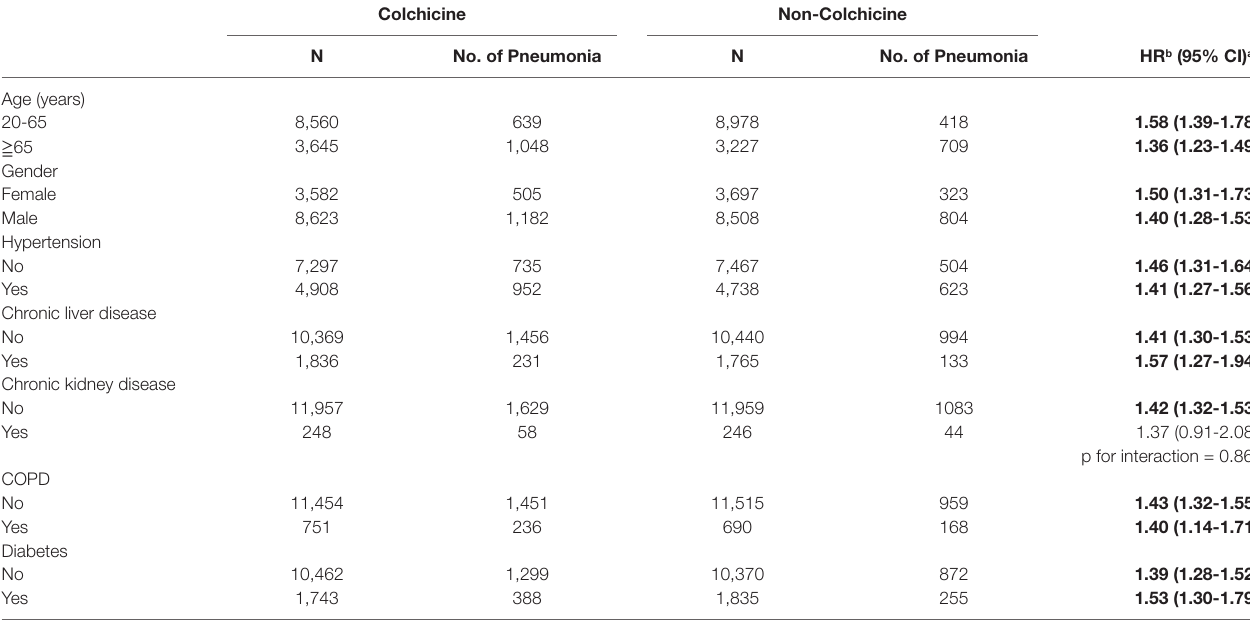
TABLE 3 | Subgroup analysis of pneumonia risk in gout patients with and without colchicine treatment by Cox proportional hazard model.